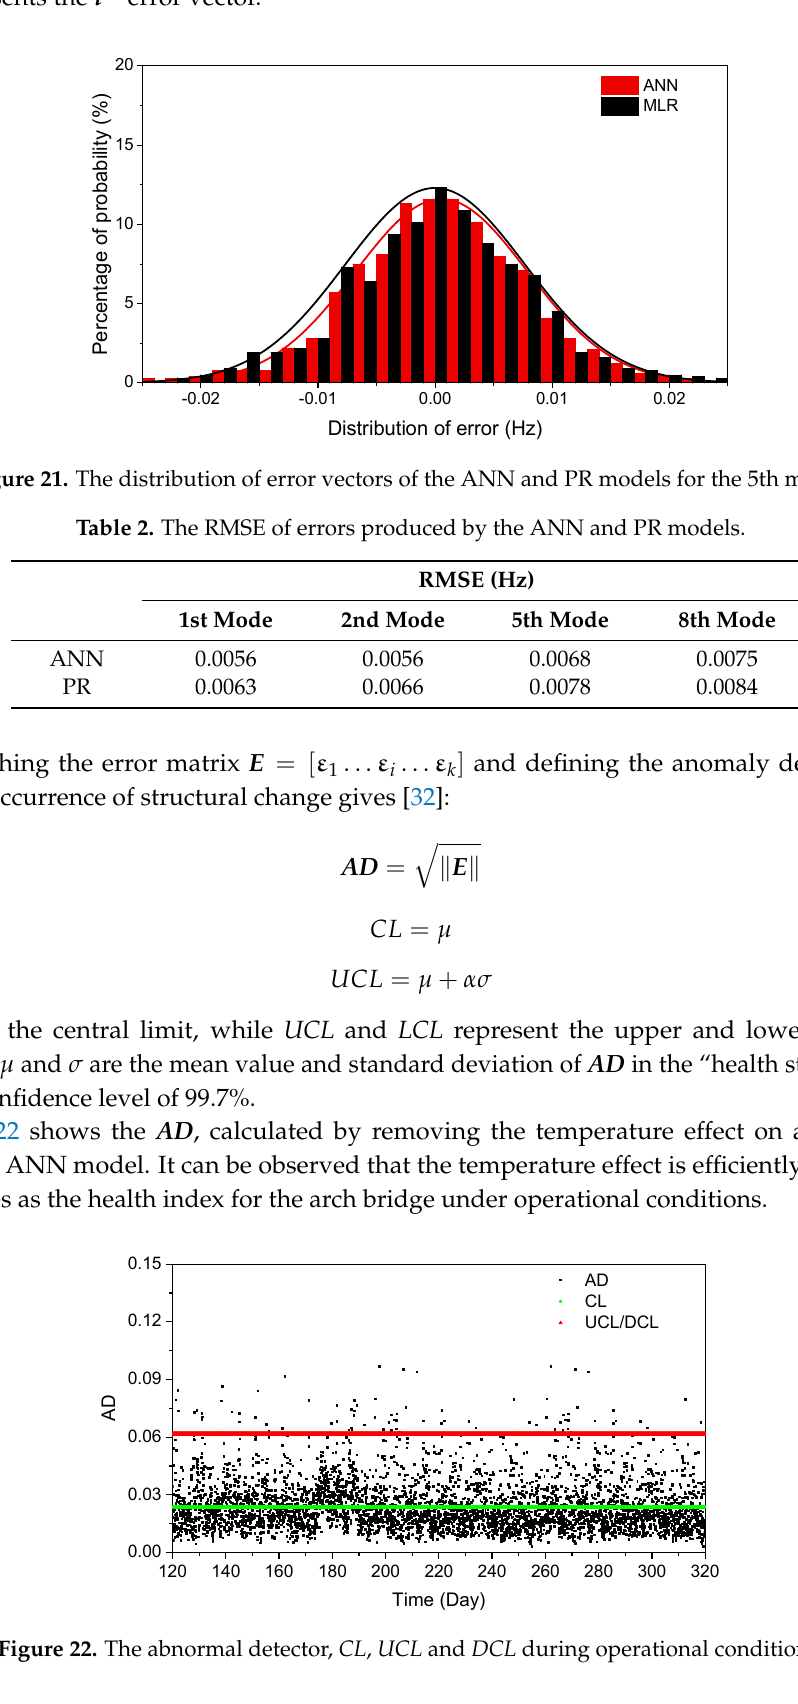
Figure 20. Comparison of ANN and PR in the fitting of identified frequencies: ( a ) the 5th mode; ( b ) the 8th mode.